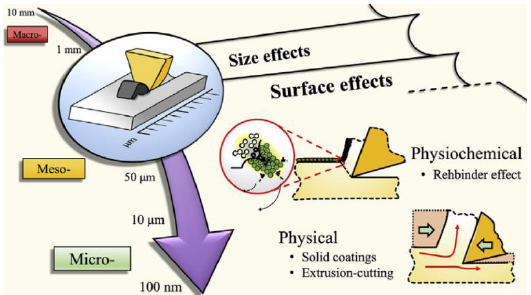
Figure 1. Indicative limits for different types of metal cutting